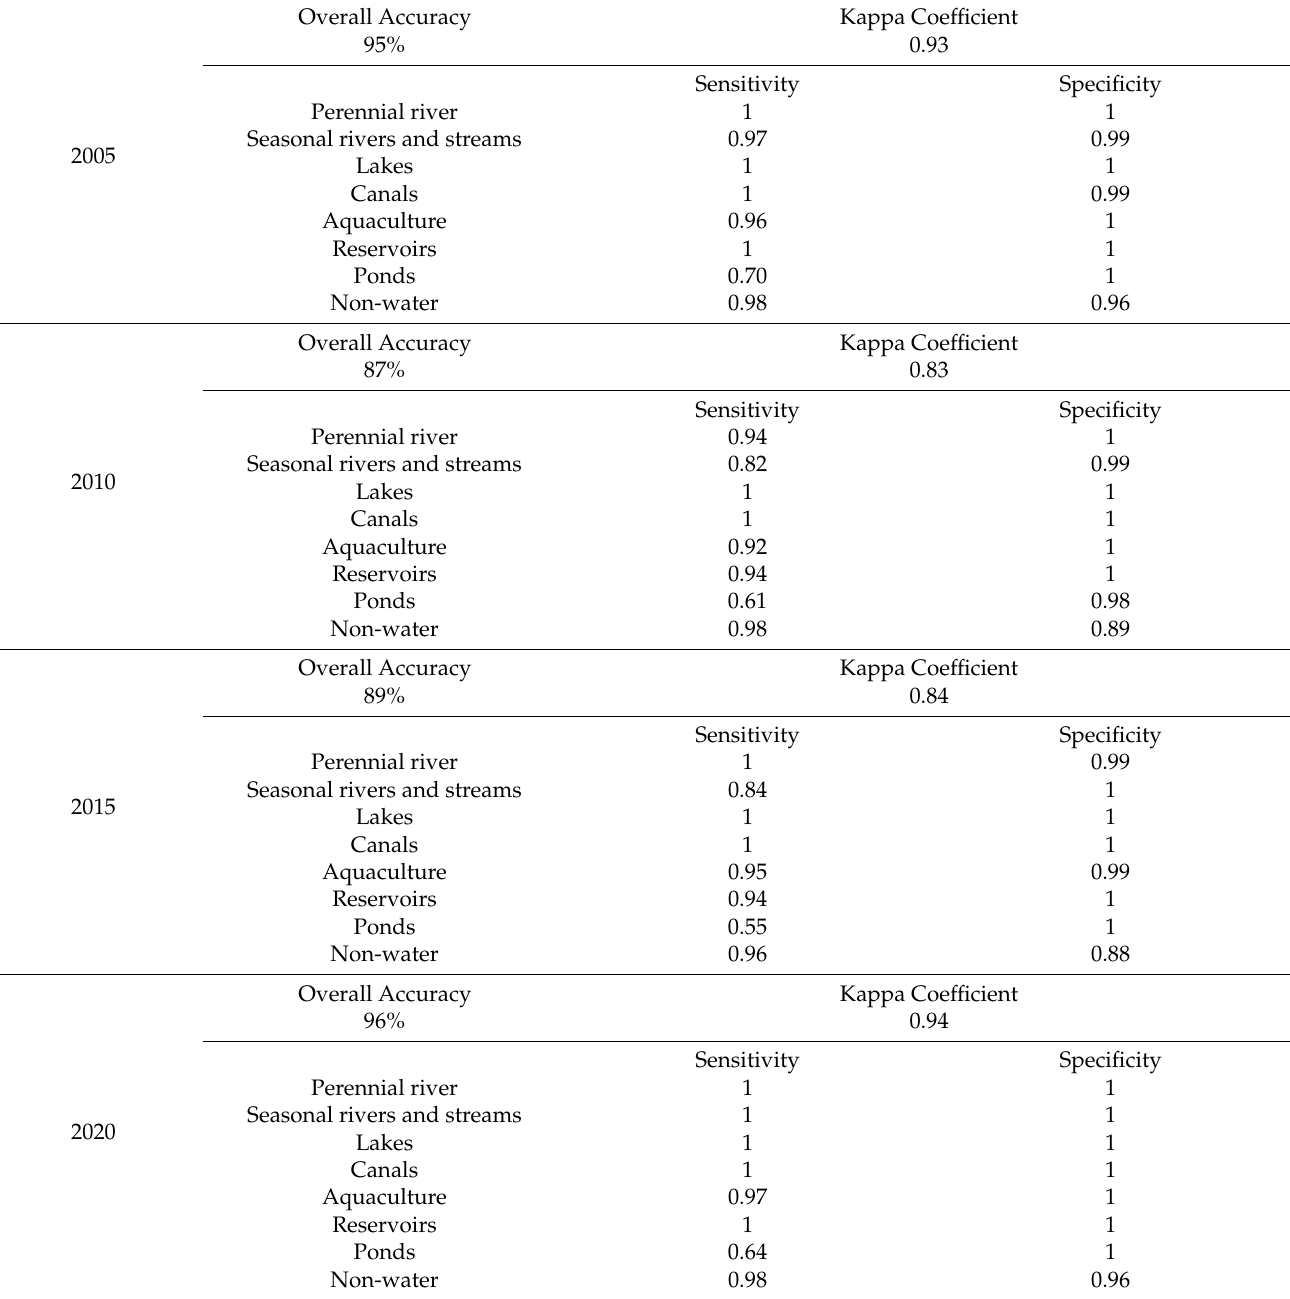
Supporting Information Figure 7. Dunn’s post hoc tests comparing dPC of different types of